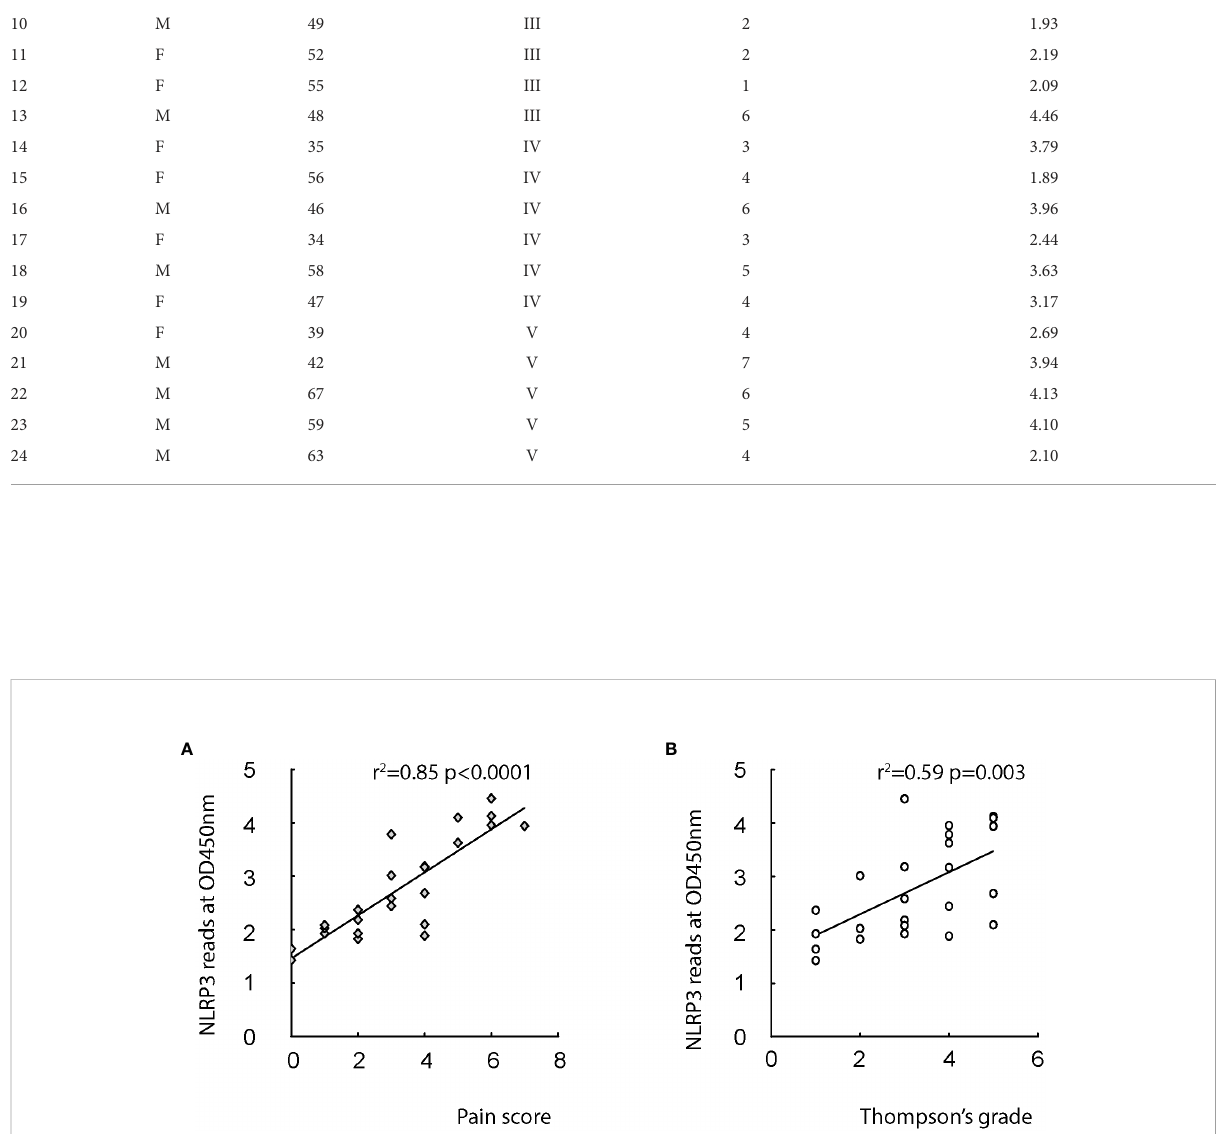
FIGURE 1 Disc NLRP3 levels correlate with the pain and disc degeneration level in LDD patients. Disc specimens from 24 participants who had different levels of Thompson classi fi cation of the degeneration and scores for pain were analyzed. (A, B) The NLRP3 protein levels in disc tissue were quanti fi ed by ELISA in all 24 specimens. Reads of NLRP3 OD values at 450nm were presented. The correlation between NLRP3 protein levels and pain score ( A , r 2 = 0.85, p<0.0001) or Thompson classi fi cation of the degeneration level ( B , p=0.003) was assessed.